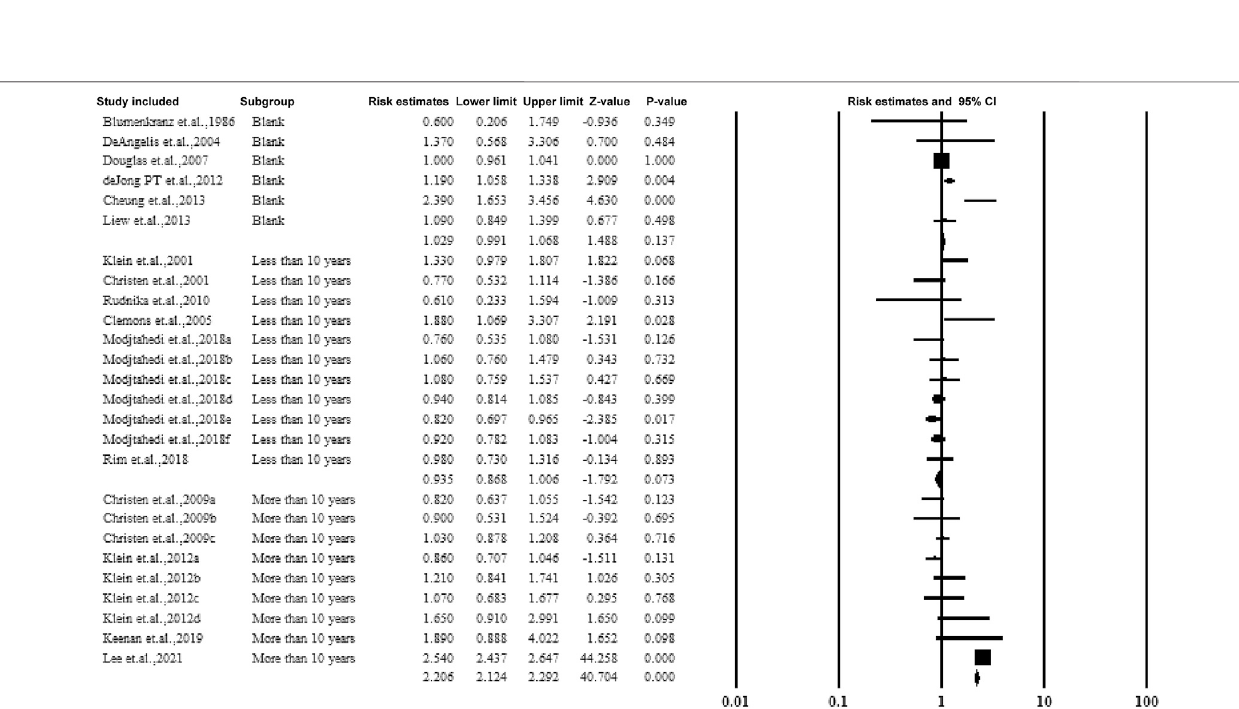
FIGURE 7 | Summarized subgroup analysis according to the follow-up years.